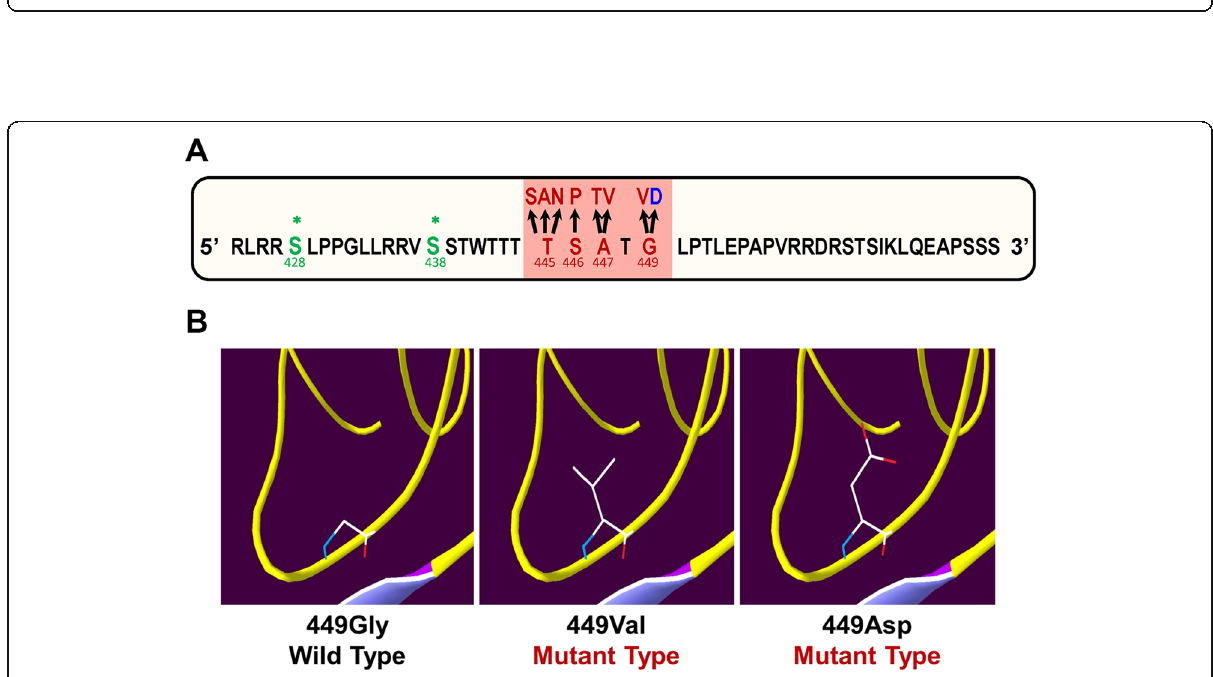
Fig. 3 Functional analysis of the pathogenic variant PDE3A -p.Gly449Asp. a The peptide sequence of PDE3A exon 4, which harbours the pathogenic variant cluster (red-coloured region), and the phosphorylation sites Ser428 and Ser438 (shown in a green colour) near the altered residues are shown. Reported pathogenic variants causing autosomal dominant hypertension with brachydactyly type E syndrome are shown in red. Our novel pathogenic variant is shown in blue. b In silico structural modelling of the two variants (p.Gly449Val-reported, p.Gly449Asp-novel) compared with the wild type in the PDE3A